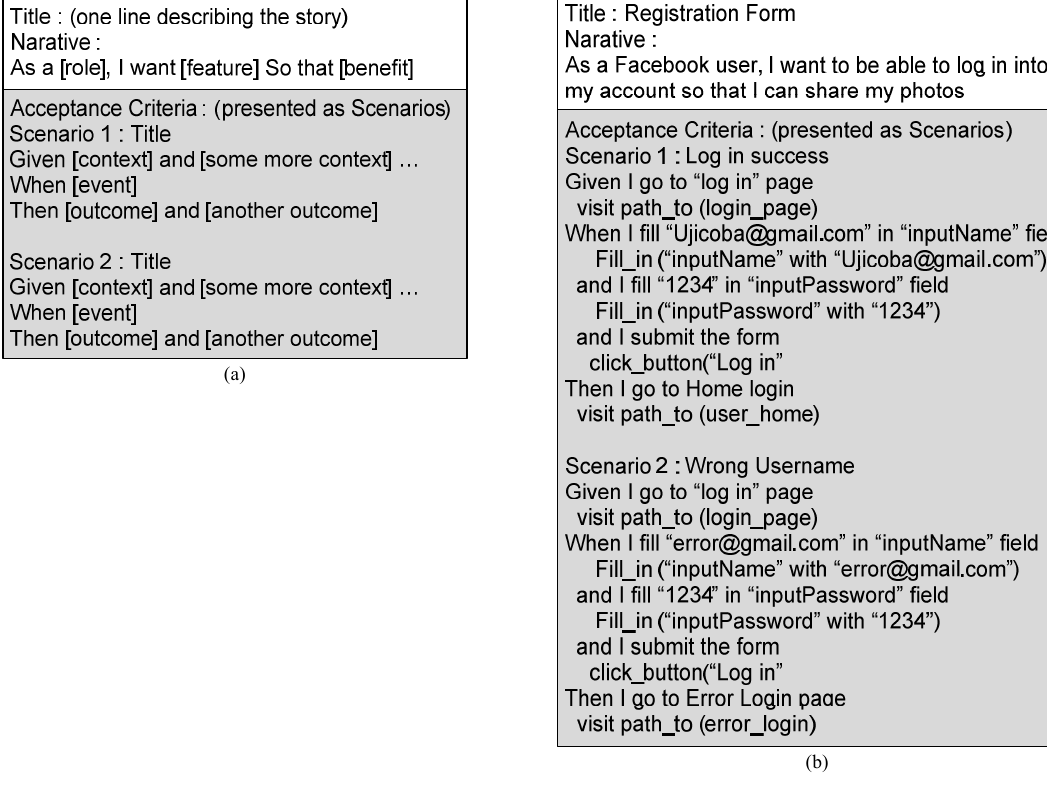
Fig. 2 Example of User Story (a) Template of User Story (Introduced by [19] and [20]) (b) An example of User Stories with 2 Scenarios